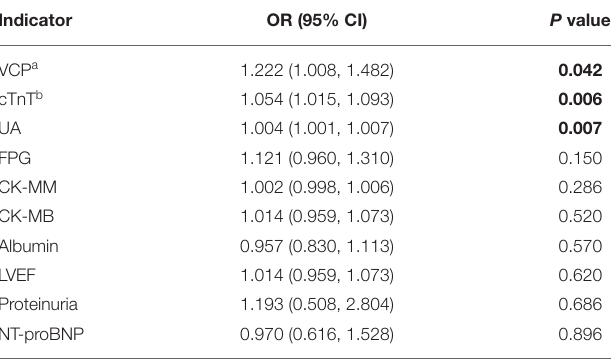
TABLE 4 | Multivariate logistic stepwise regression analysis of ACS and candidate indicators (all indicators increase by 1 unit unless otherwise specified).